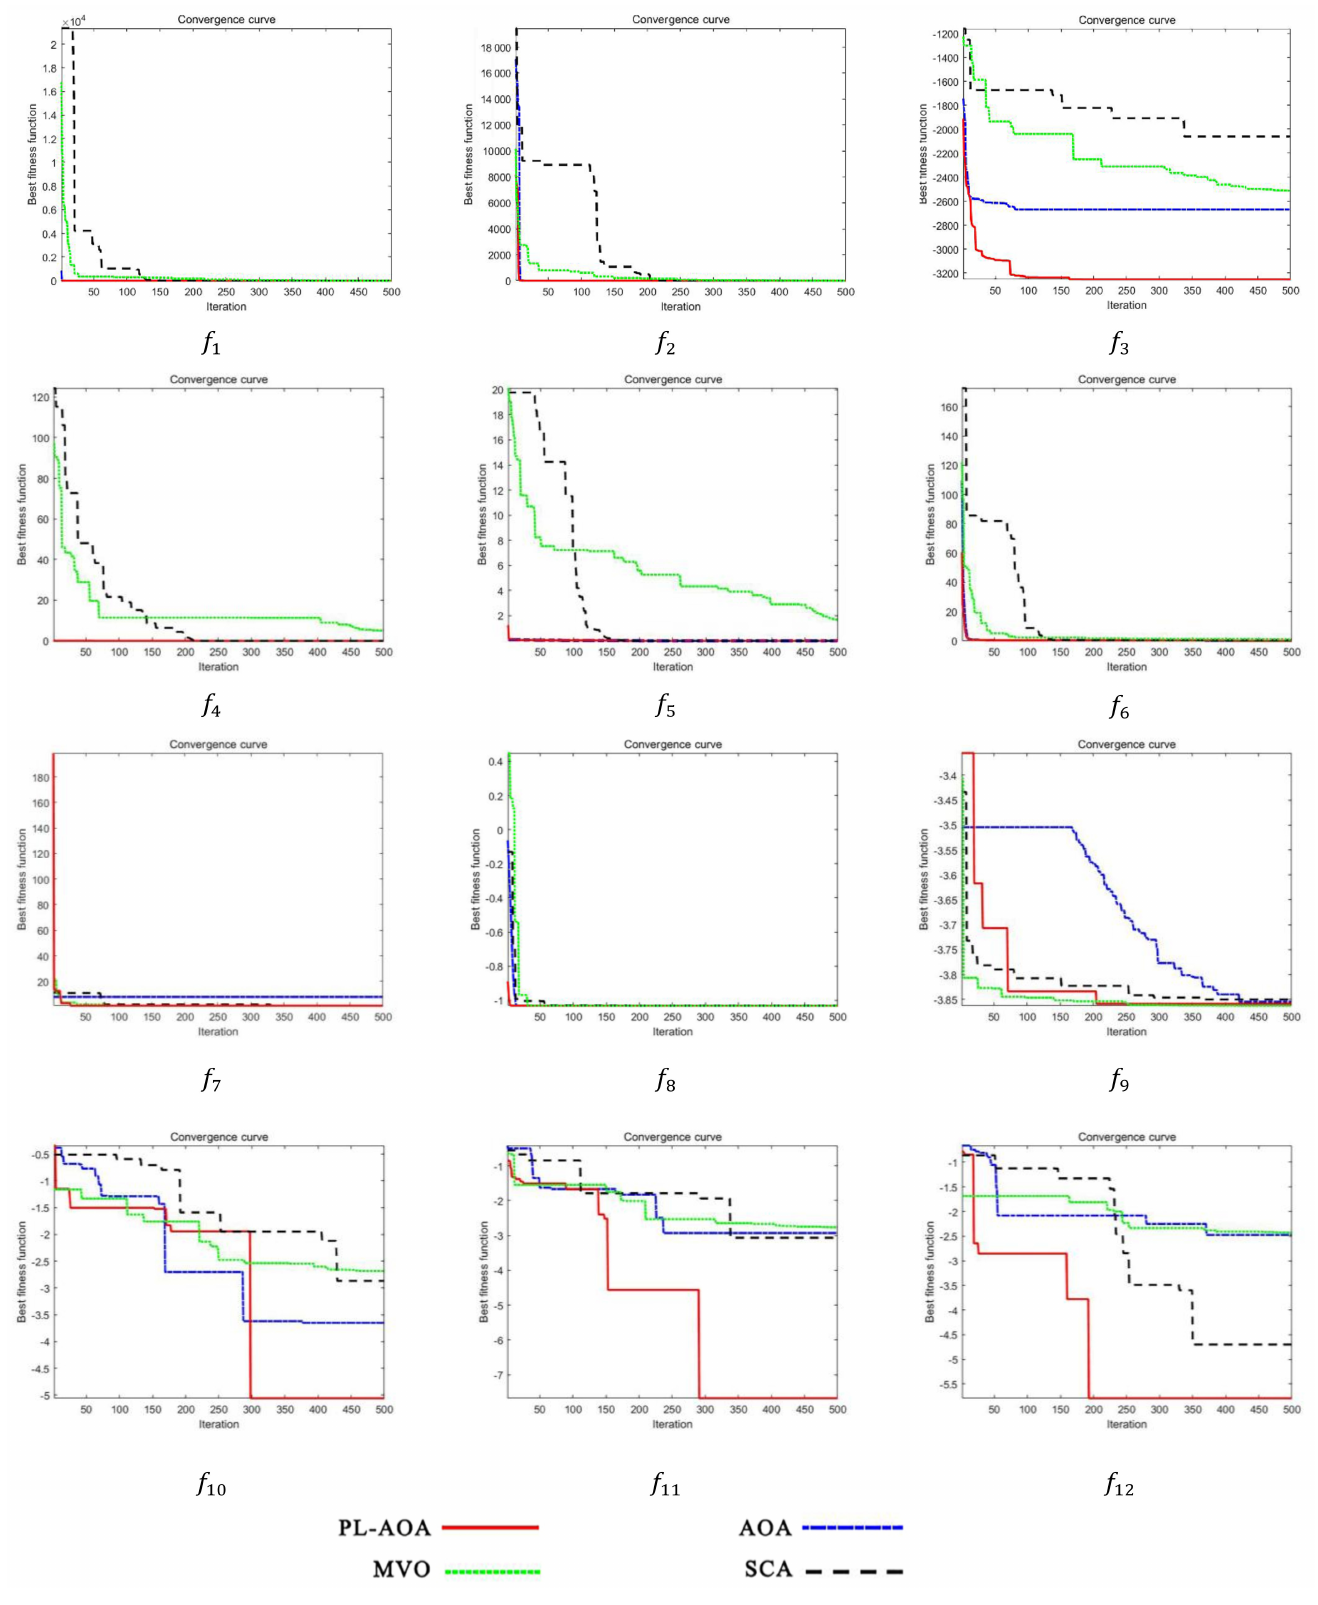
Figure 4. The convergence curves of test